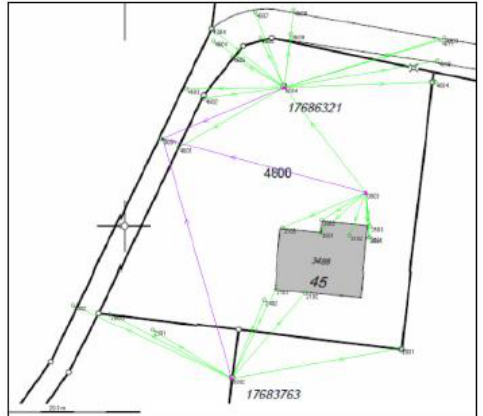
Figure 4. Site map from the Swiss official cadastral surveying including the achieved measurements using tachymetry/GNSS (test site Krattigen) Figure 4 shows four reference points measured with GNSS serving as basis for the major street points and building edges